Question: Author a descriptive caption for the visualization shown.
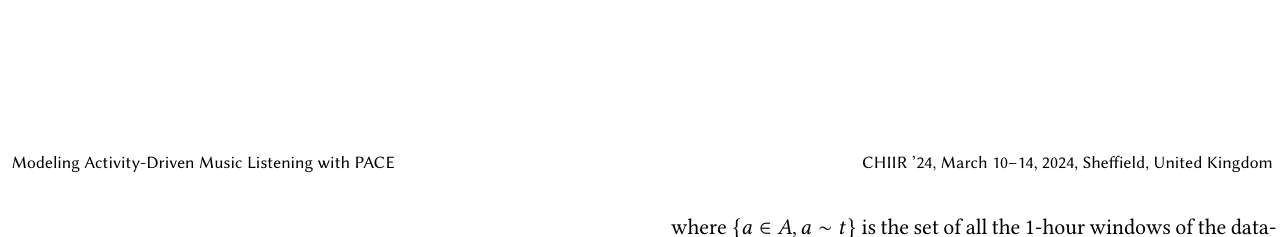
Answer: Aggregation process for a particular user: stream count over the whole dataset (top), weekly scale aggregation (middle), after convolution and normalization (bottom).